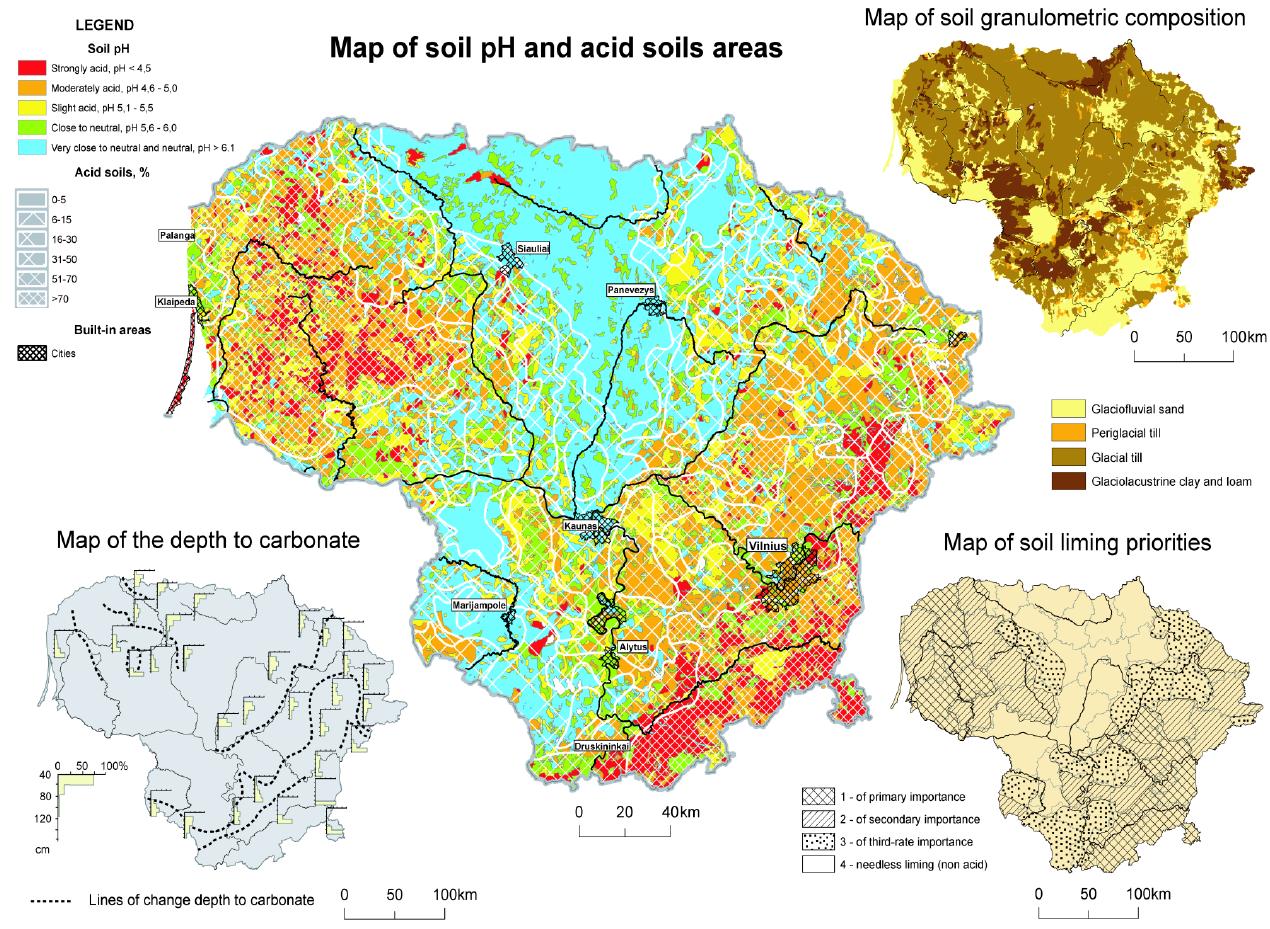
Fig. 2. National map of soil